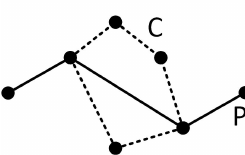
Figure 5. A chording